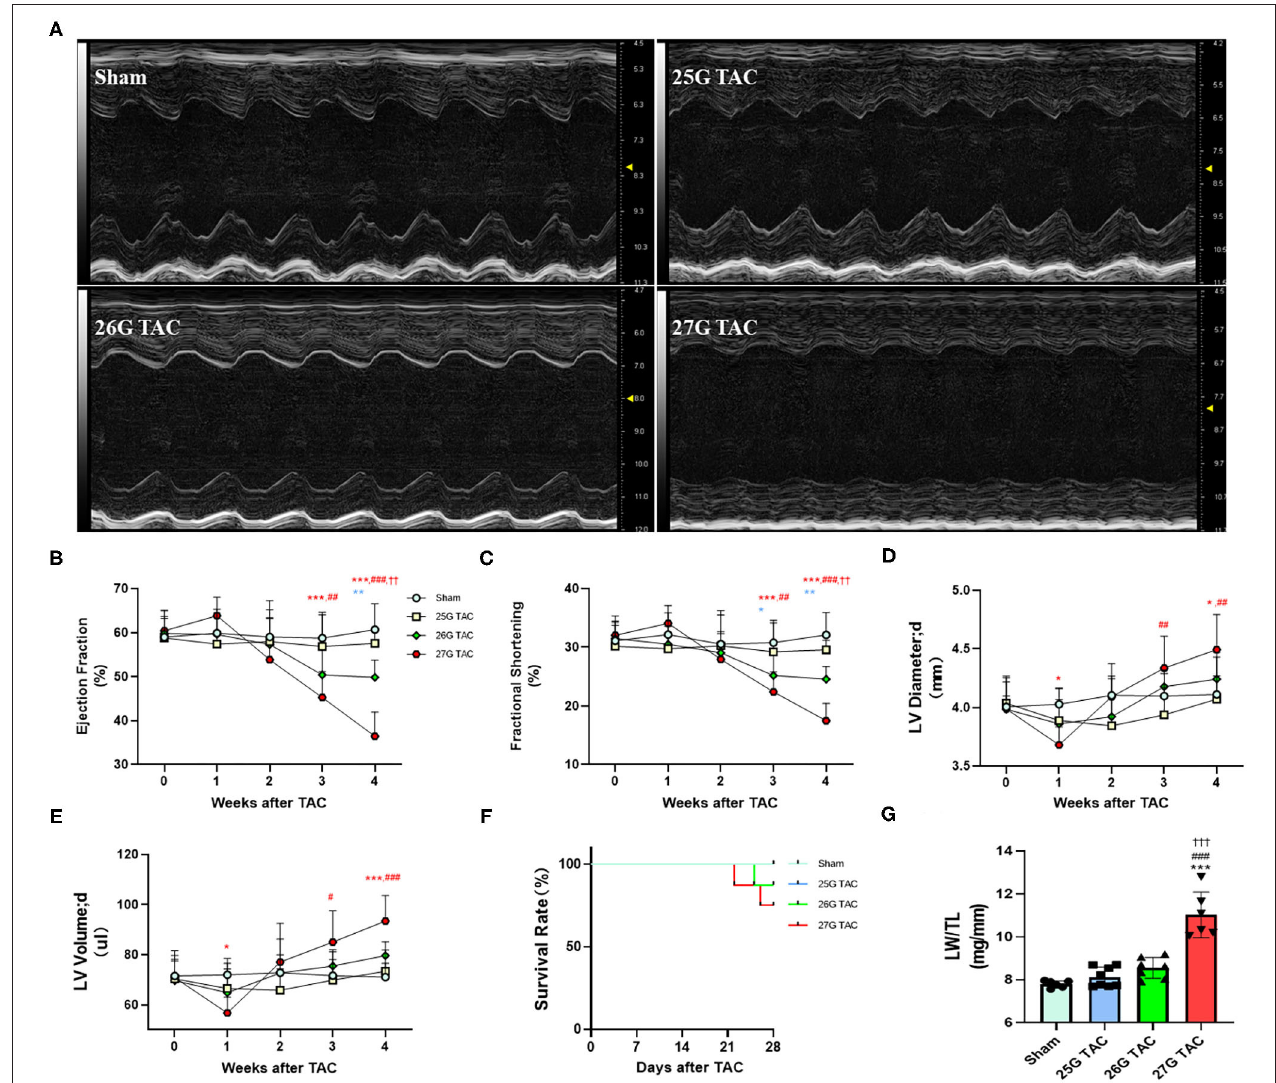
FIGURE 3 | 25, 26, and 27G TAC induced different degrees of reduction of cardiac function in C57BL/6N mice. The echocardiography-derived results of (A) representative images of M-Mode images after 4 weeks of TAC show systolic dysfunction, (B) EF, (C) FS, (D) the end-diastolic LV diameter, and (E) the end-diastolic LV volume. (F) Kaplan–Meier survival curves. (G) LW/TL. *** P < 0.001 vs. sham, ### p < 0.001 vs. 25G, ††† P < 0.001 vs. 26G TAC by two- (B–E) or one-way ANOVA (G) with Tukey’s post-test. Colored symbols (A–C) indicate * P < 0.05, ** P < 0.01, and *** P < 0.001 vs. sham, # P < 0.05, ## p < 0.01, ### p < 0.001 vs. 25G, †† P < 0.01 vs. 26G TAC at the time point